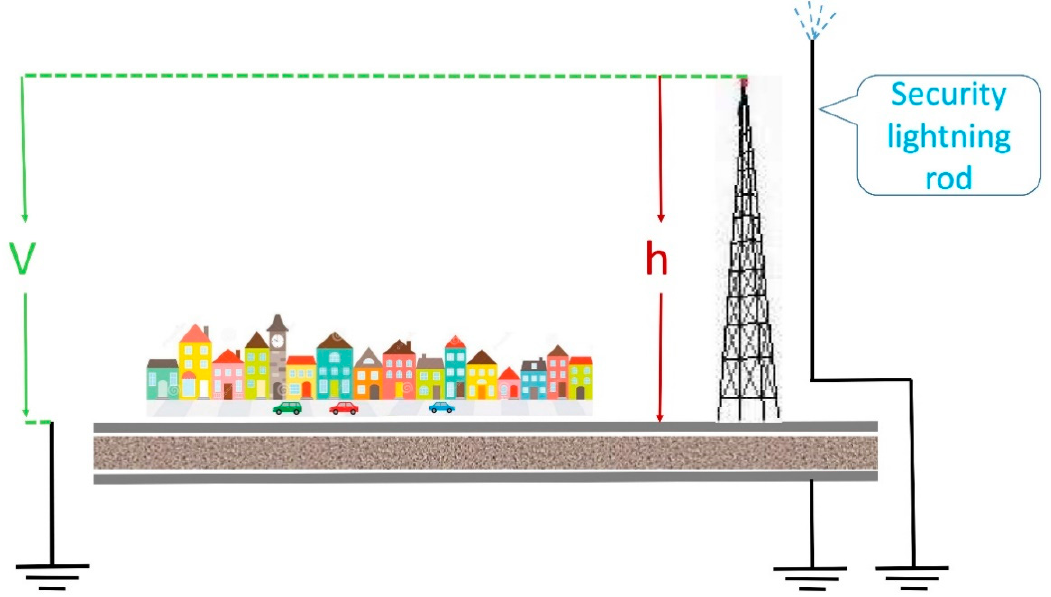
Figure 15. Exploitation of atmospheric electrostatic energy by means of a large condenser of capacitance C. The lower plate is grounded. The upper plate has a tower (or tall building) electrically connected to the plate. See text. Out-of-scale sketch.